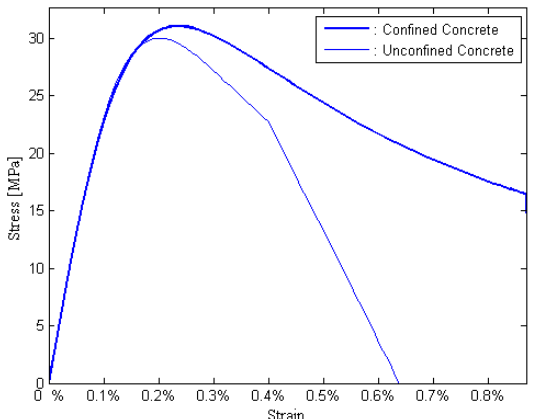
Figure 6. Unconfined and confined stress–strain law obtained with the BLG model.